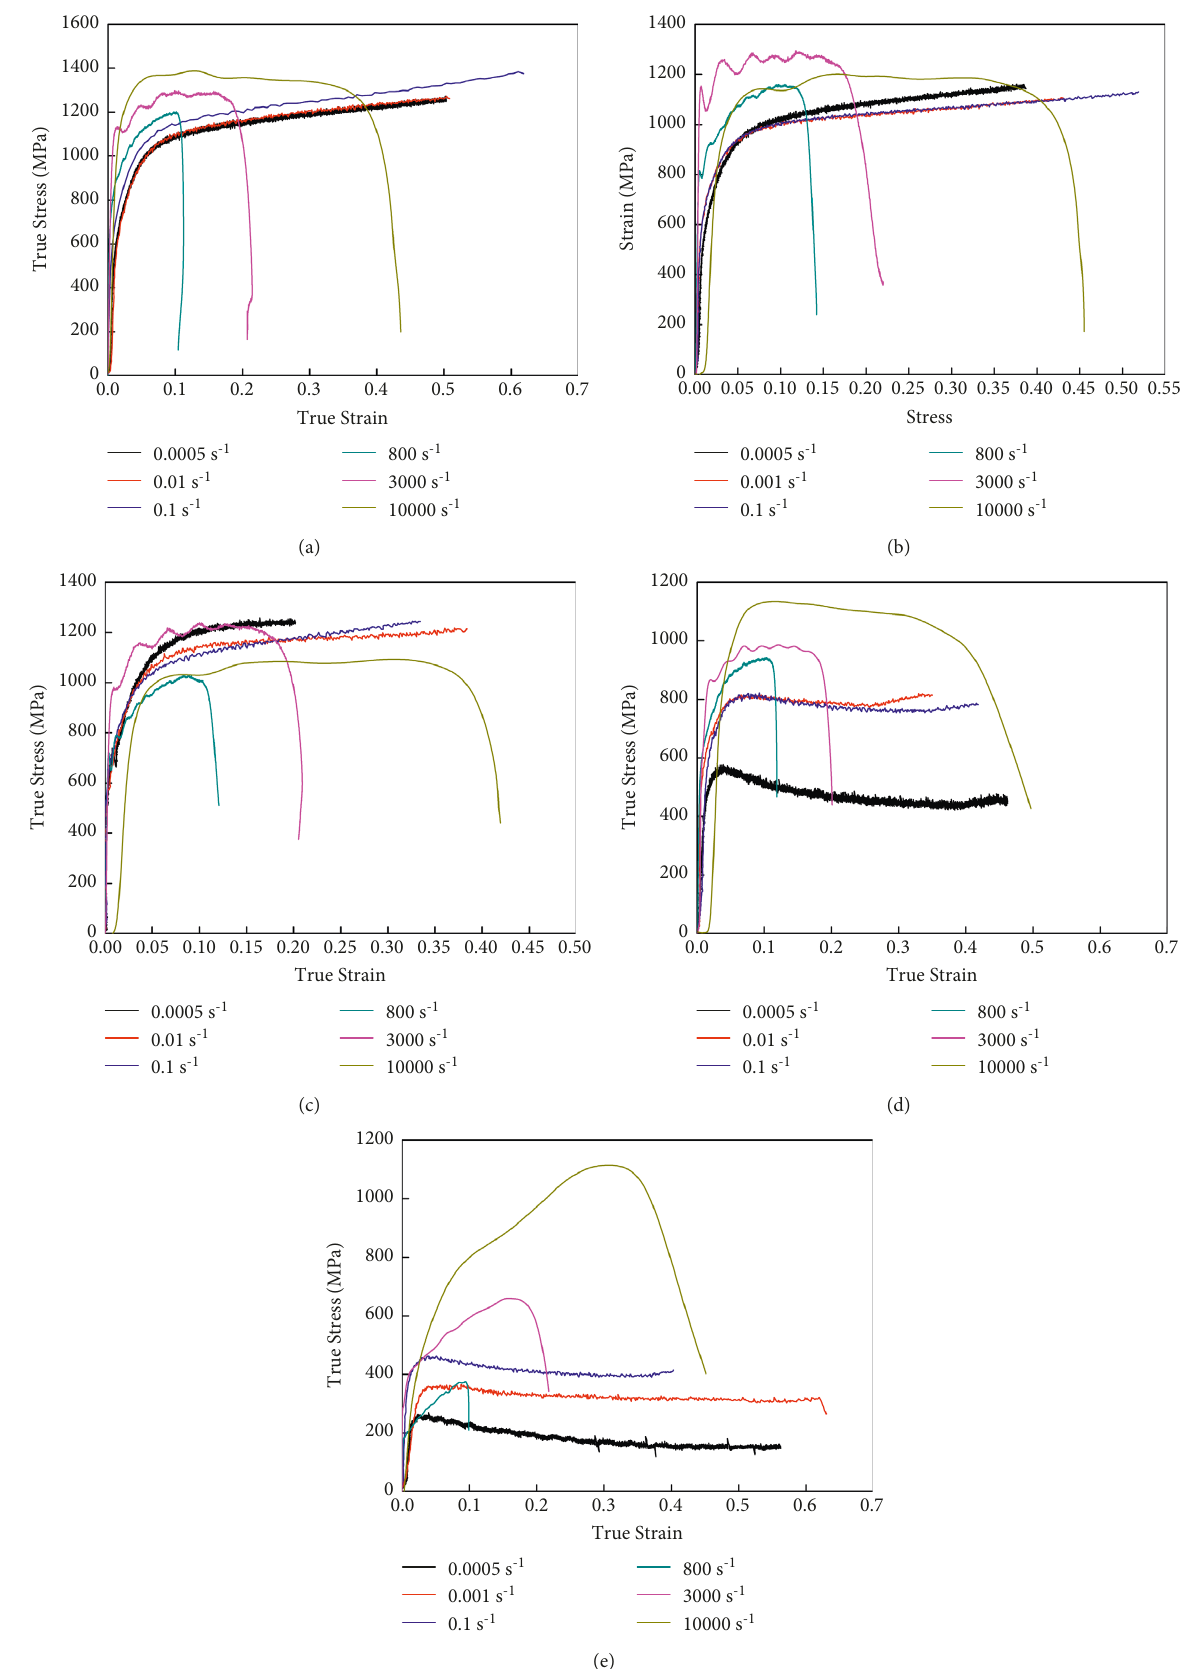
Figure 4: True stress-strain curves of U71Mn rail steel at different temperatures. (a) Experimental temperature: 25 ° C. (b) Experimental temperature: 200 ° C. (c) Experimental temperature: 400 ° C. (d) Experimental temperature: 600 ° C. (e) Experimental temperature: 800 °